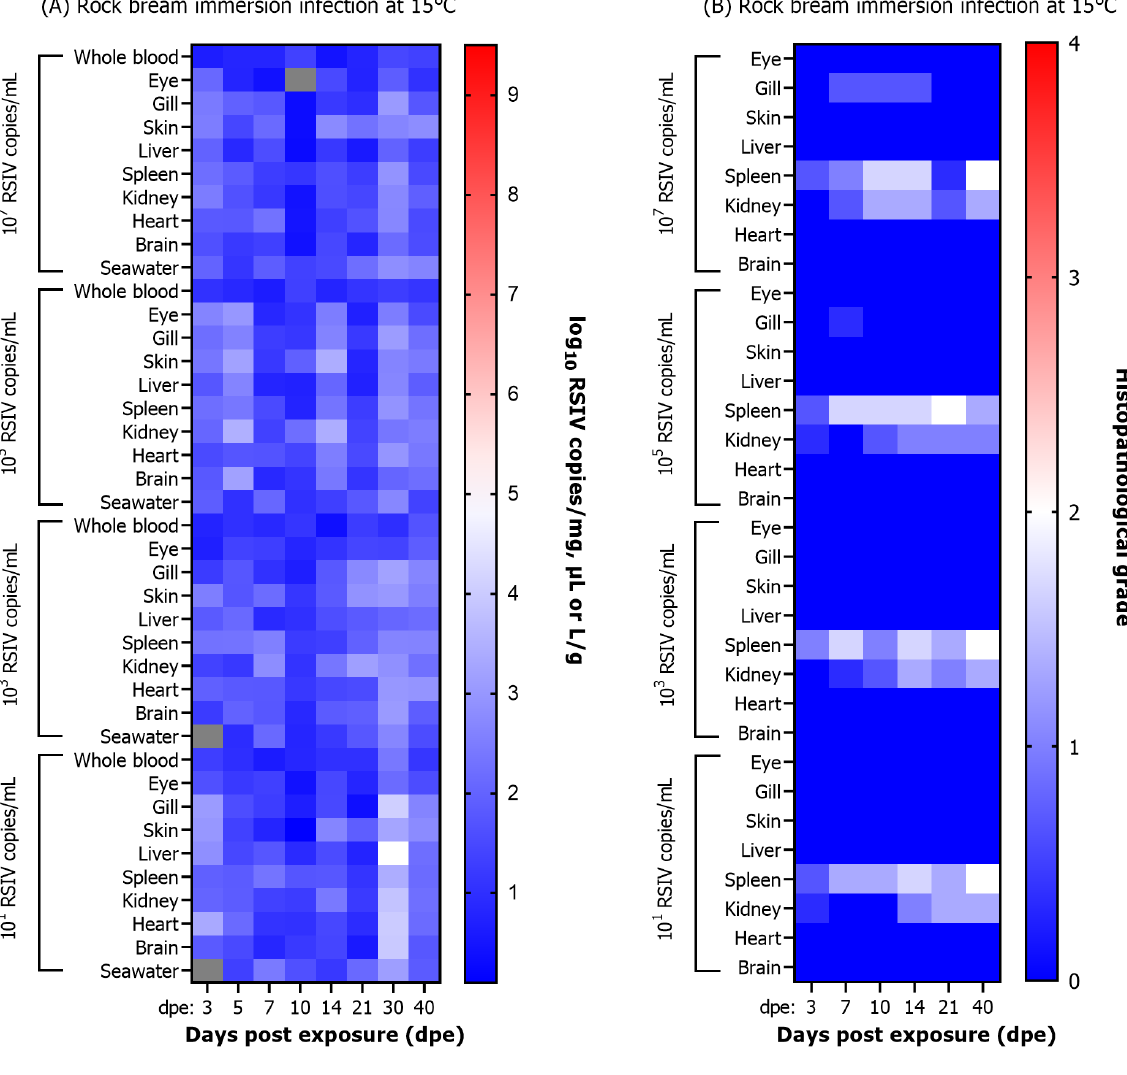
Figure 5. ( A ) Viral load and ( B ) histopathological grade results after immersion exposure with red sea bream iridovirus (RSIV) at four concentrations (final concentrations: 10 7 , 10 5 , 10 3 , and 10 1 RSIV copies/mL) in rock bream ( Oplegnathus fasciatus ) at 15 ◦ C. The box represents the average of three fish. ( A ) Gray boxes show no RSIV detected in fish and seawater.